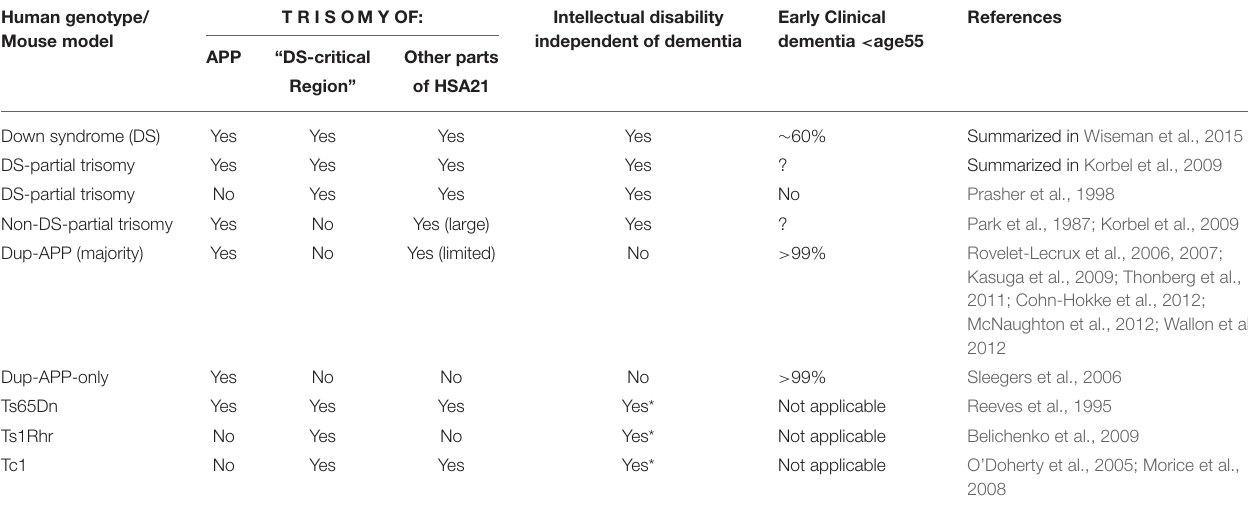
TABLE 1 | Effects of the trisomy of APP and other segments of human chromosome 21 on development of intellectual disability (independently of dementia), and on presence of early clinical dementia. Human genotype/ Mouse